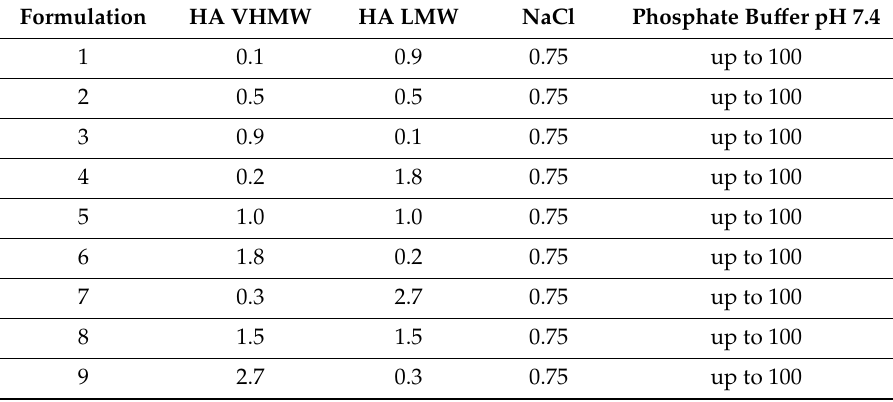
Table 2. % (w / v) composition of the formulations of the full factorial design.